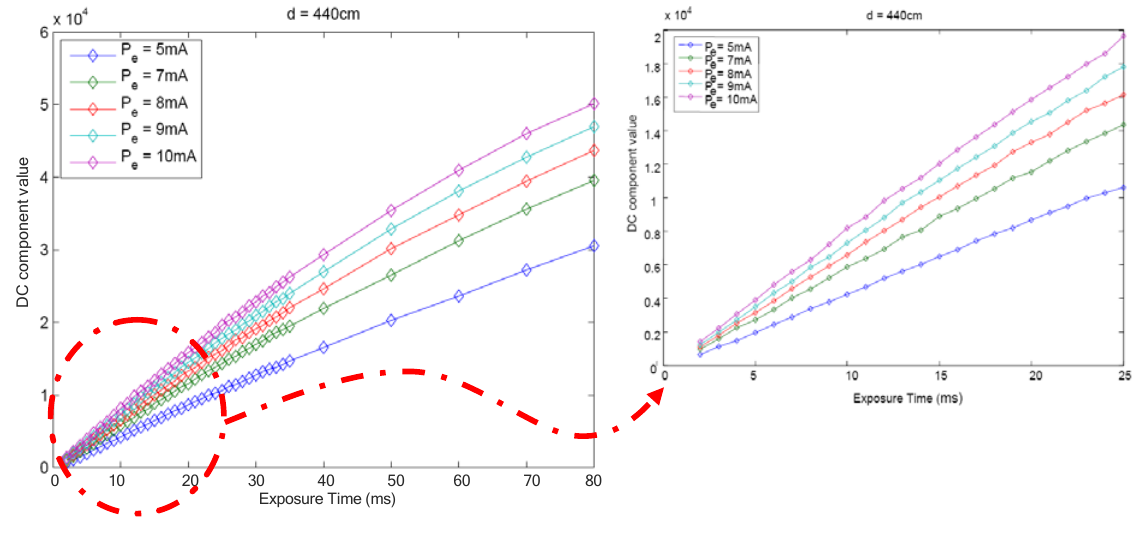
Figure 3. Behavior of the DC component with the camera exposure time for different emitter radiant intensities.